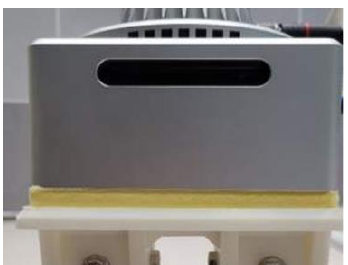
Figure 5. Vibration reduction device